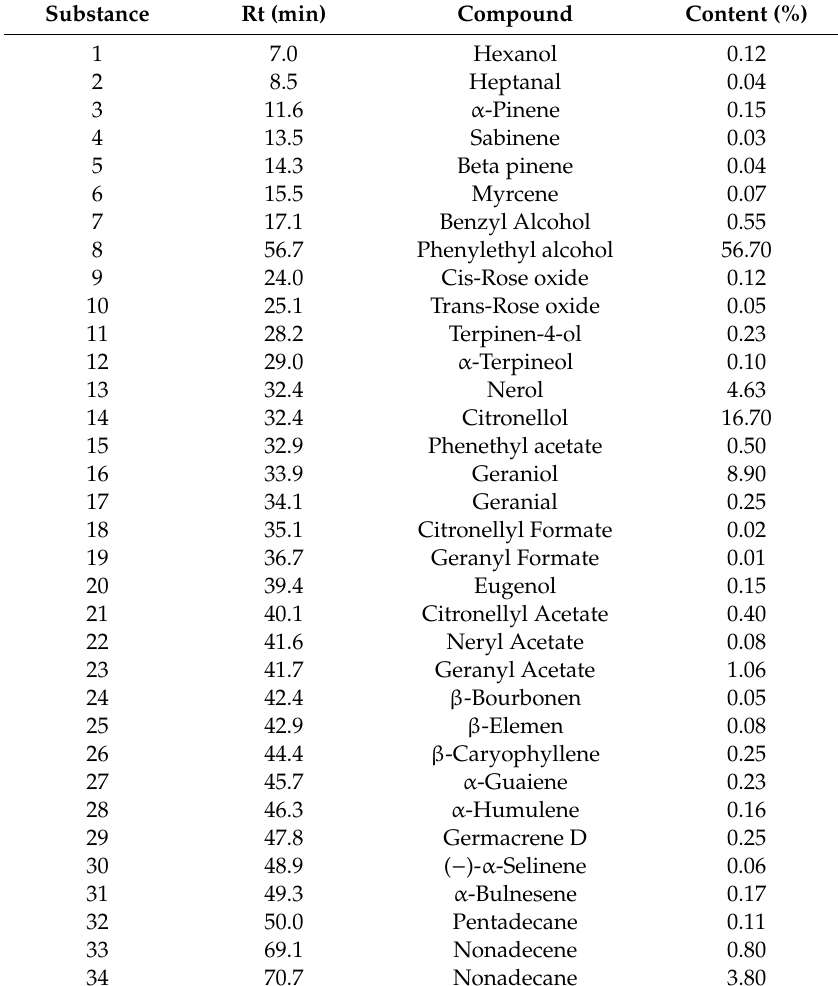
Table 1. Volatile constituents identified in Rosa damascena mill. flower